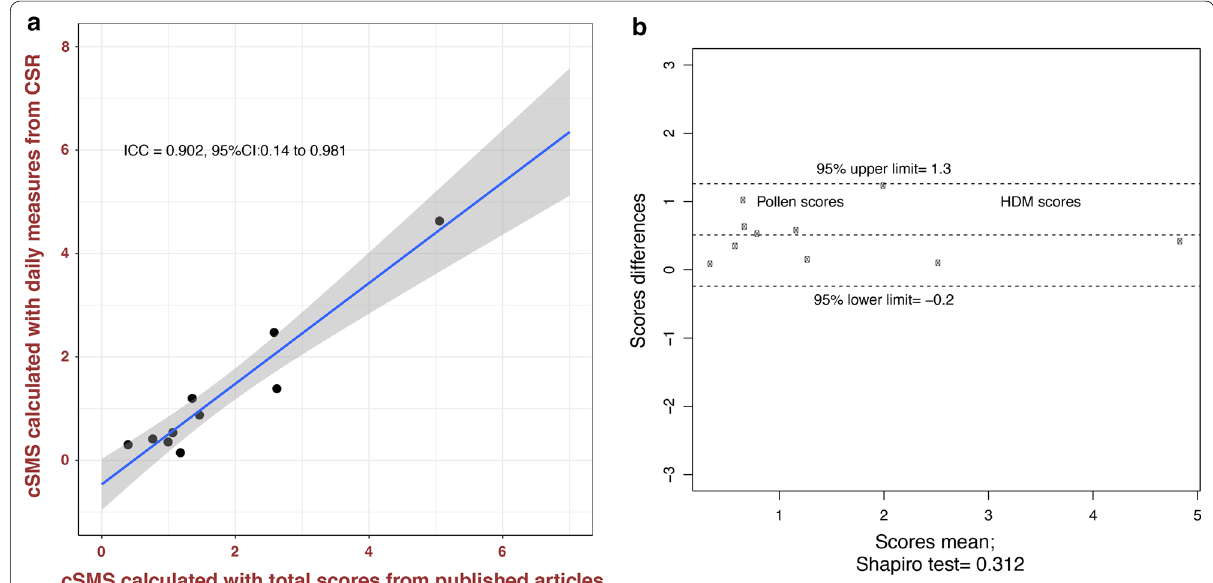
Fig. 3 Agreement between cSMS calculated with daily measures from CSR and calculated with total scores in a Scatter plot ( a ) and Bland–Altman plot ( b ). From published articles in all study seasons [9–16]. a The points represent the intersection between the two cSMS values (cSMS calculated with daily measures from the CSR and calculated with total scores from published articles). Strong agreement can be observed between the two measurements (ICC: 0.902, 95% CI: 0.14–0.981). b The X‑axis represents the sum of two cSMS values divided by two; the Y‑axis represents the differences between the two measures of cSMS. Strong agreement between the two measurements can be seen because there are no points outside the 95% limits of agreement (dashed lines). It is common to compute 95% limits of agreement for each comparison (average difference 1.96 standard deviation of the difference), which tell us how far apart measurements observed using two methods were more likely ± to be for different cases. Contrary to expectations, in the articles that published cSMS the two measures are not equal. There are slight differences between cSMS values extracted from clinical study reports (CSRs) and those extracted from publications. This is due to the fact that in the published articles provided only the median and range, and therefore they should be transformed to mean and standard deviation. Whereas in the CSRs the mean and the standard deviation were available. cSMS combined symptoms and medication score, CSR clinical study report, HDM house dust mite, ICC intra‑class correlation coefficient